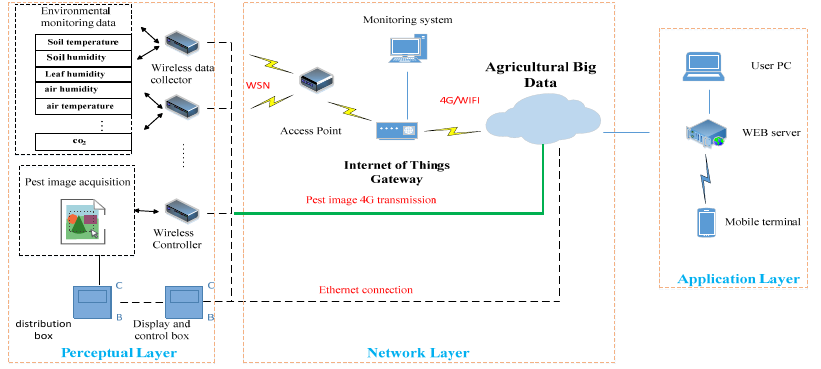
Figure 1. Structure of vegetable pest warning system that is based on multidimensional big data ( VPWS - MBD ).